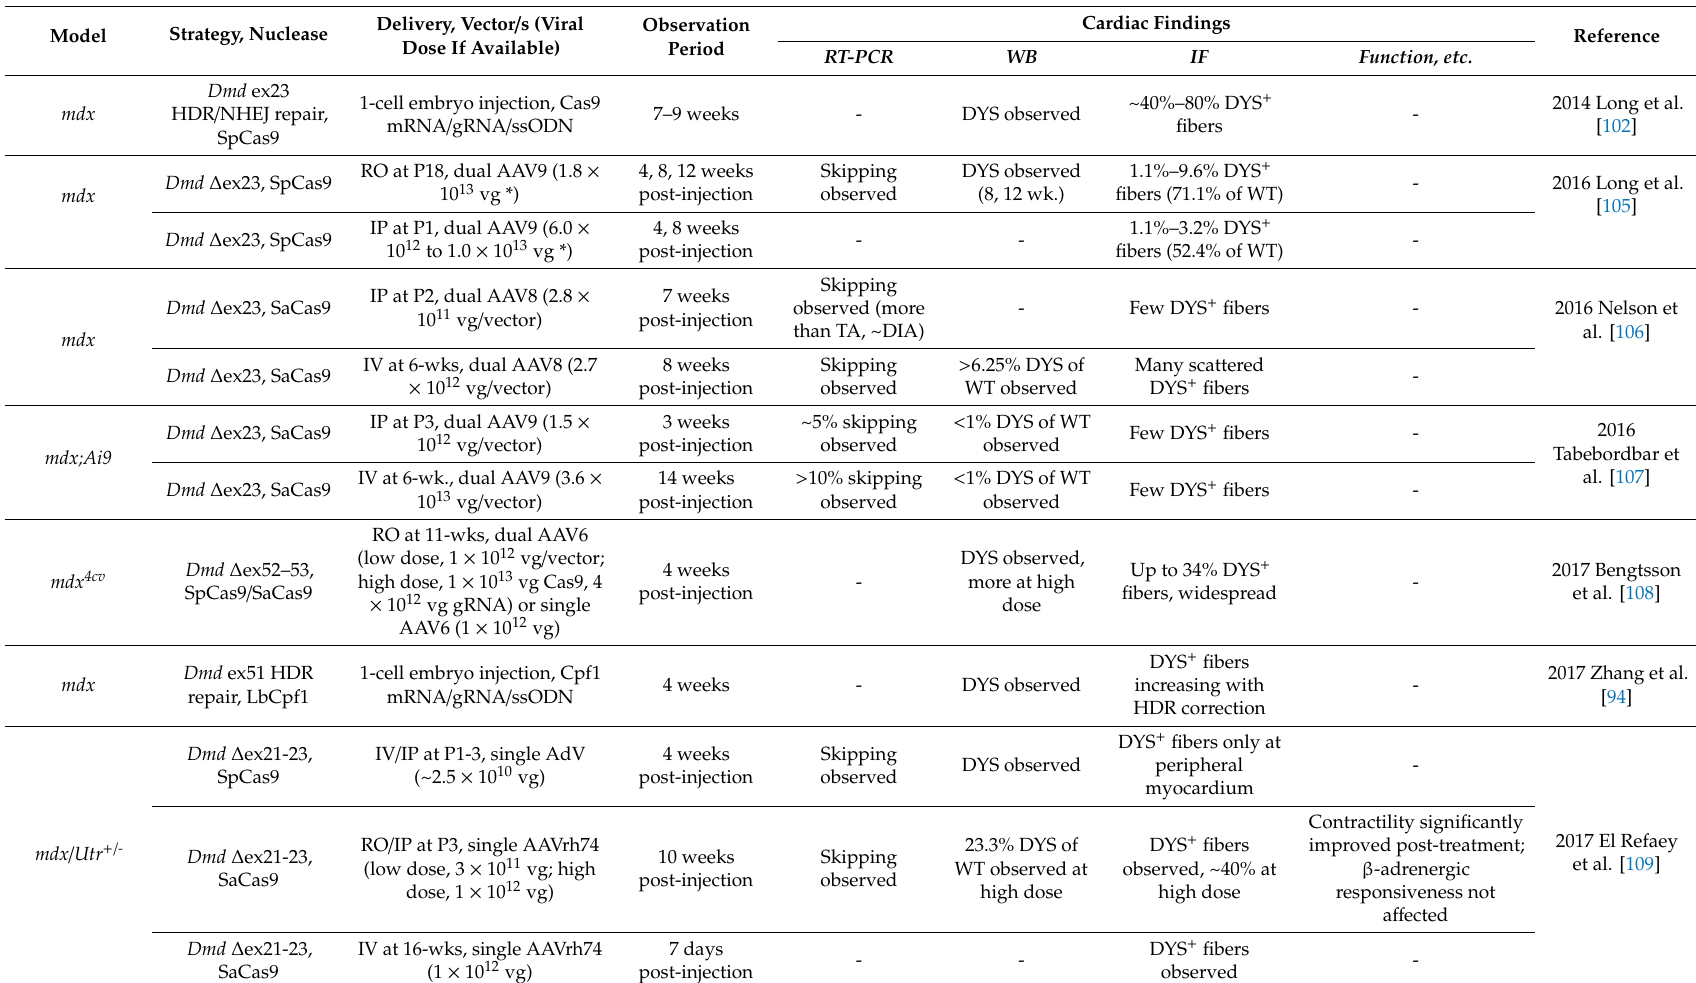
Table 2. CRISPR studies on DMD treatment using animal models, with cardiac-related